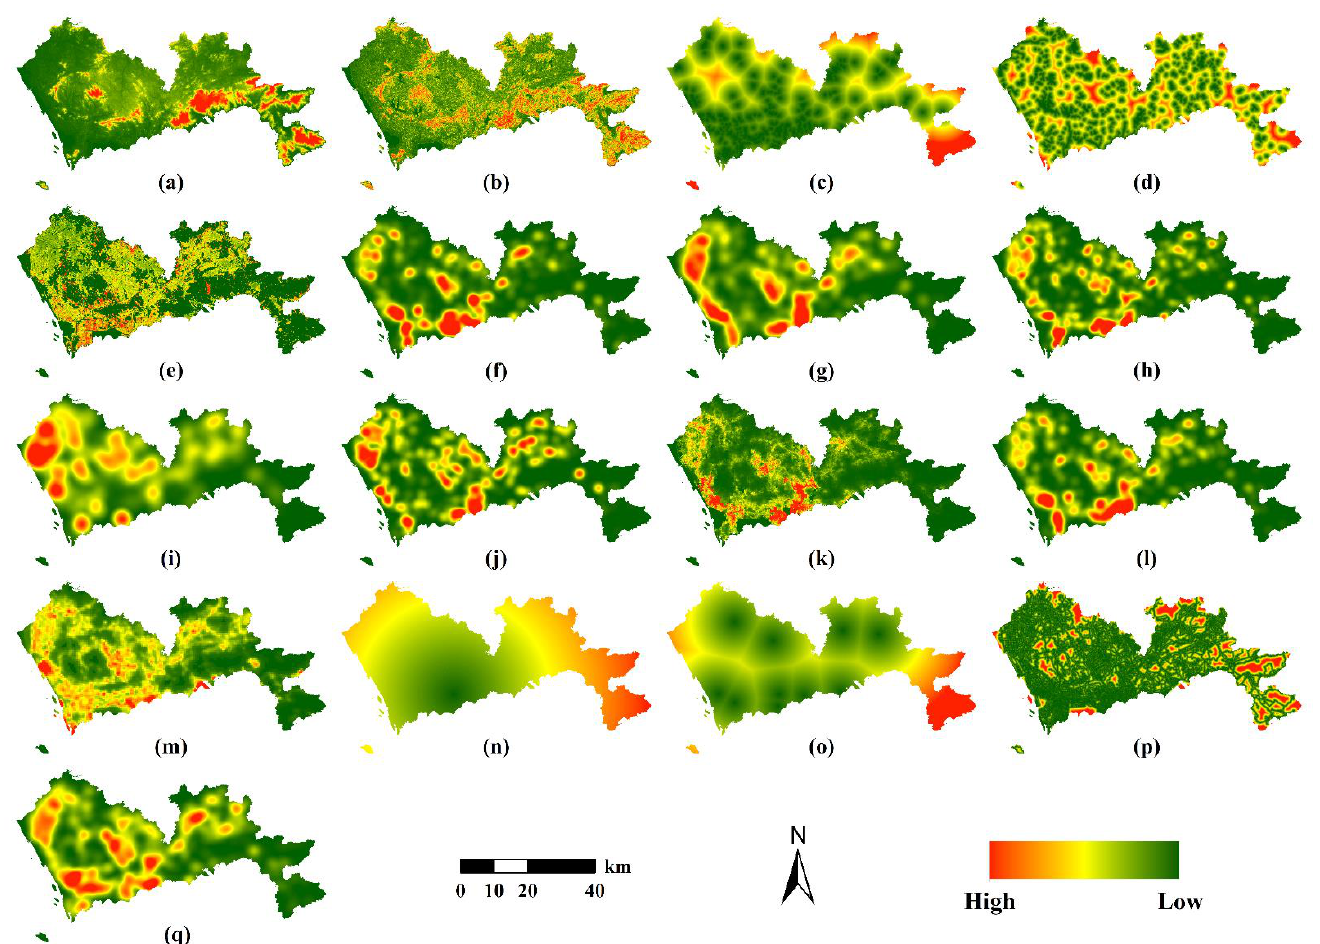
Figure 5. Spatial factors of building heights in Shenzhen. ( a ) DEM; ( b ) slope; ( c ) distance to parks and green spaces; ( d ) distance to waters; ( e ) housing prices; ( f ) density of entertainment facilities; ( g ) density of supermarkets; ( h ) density of restaurants; ( i ) density of factories; ( j ) density of shopping malls; ( k ) population density; ( l ) density of hospitals; ( m ) nighttime light intensity; ( n ) distance to city center; ( o ) distance to district centers; ( p ) distance to urban roads; ( q ) density of bus stations.